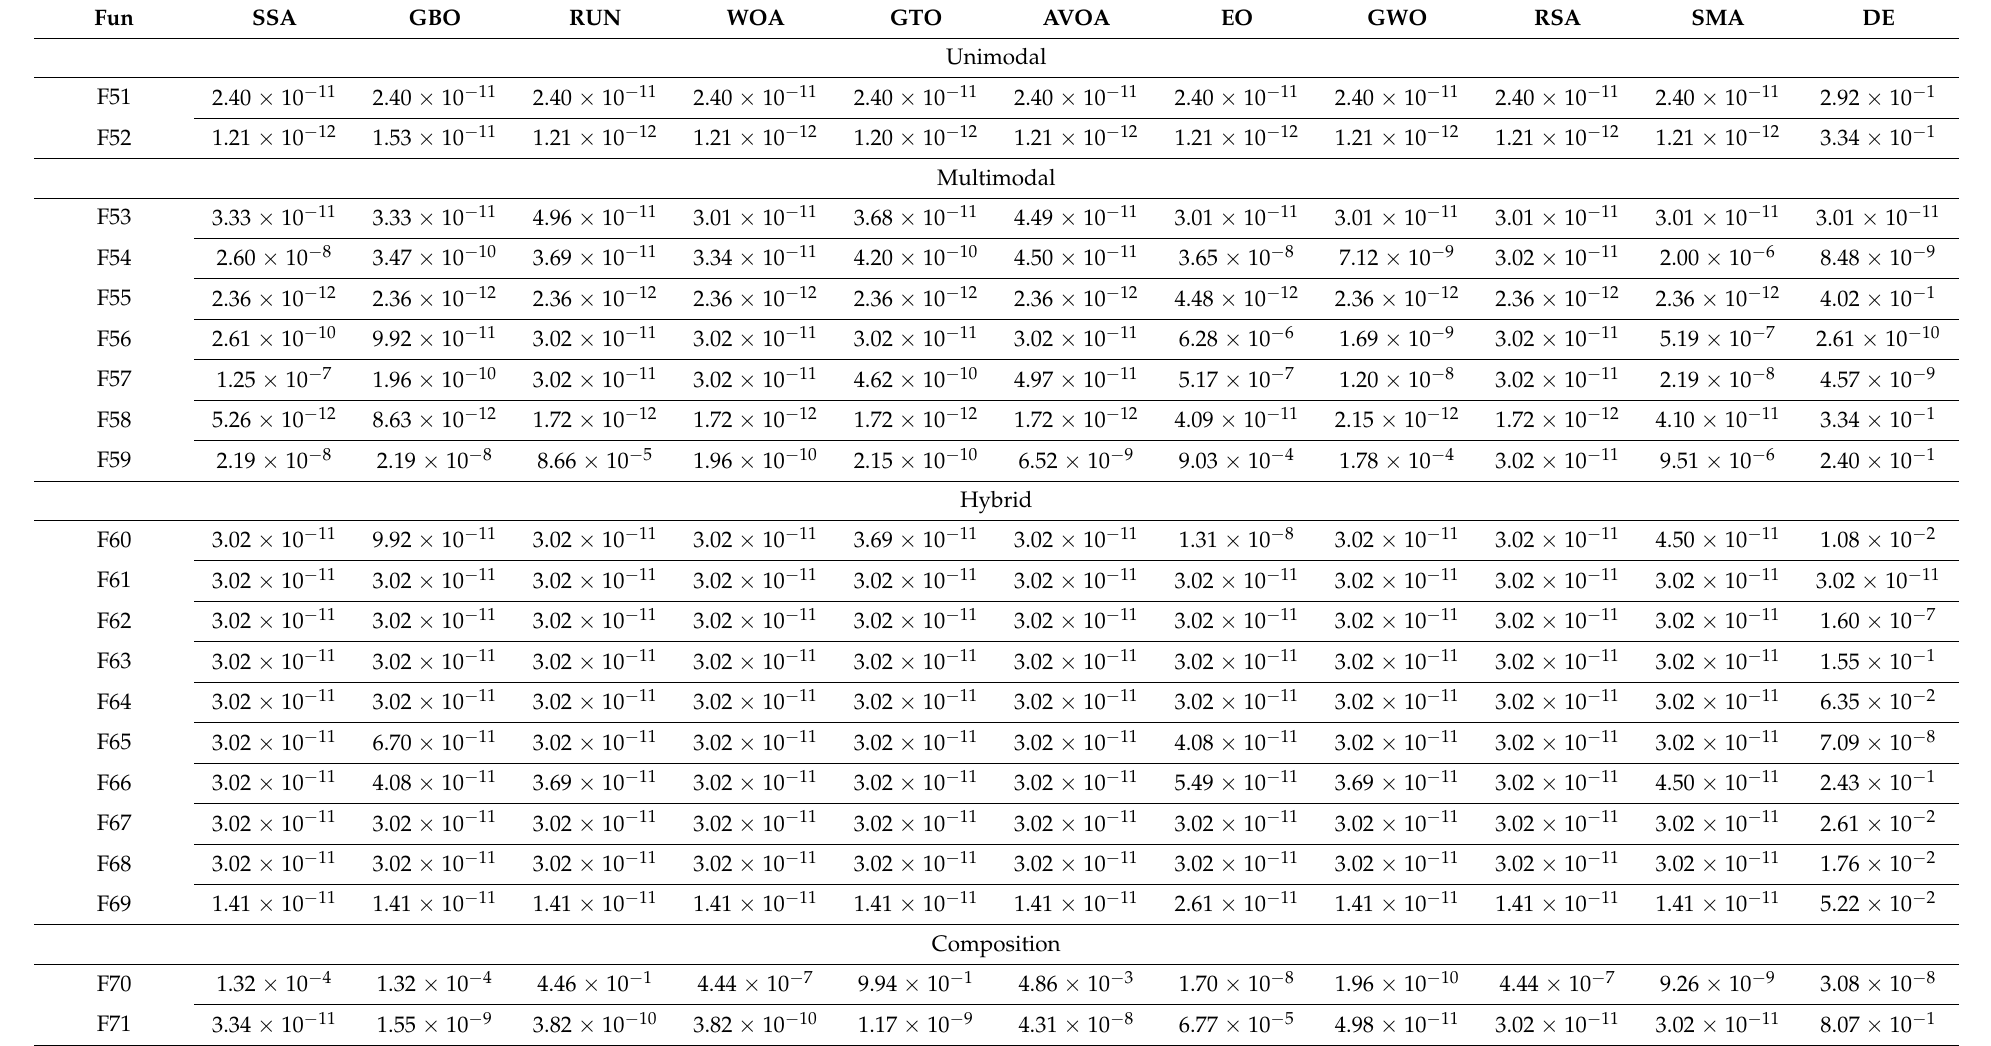
Table 11. p -values of LSO with each rival optimizer on CEC-2017 test suite